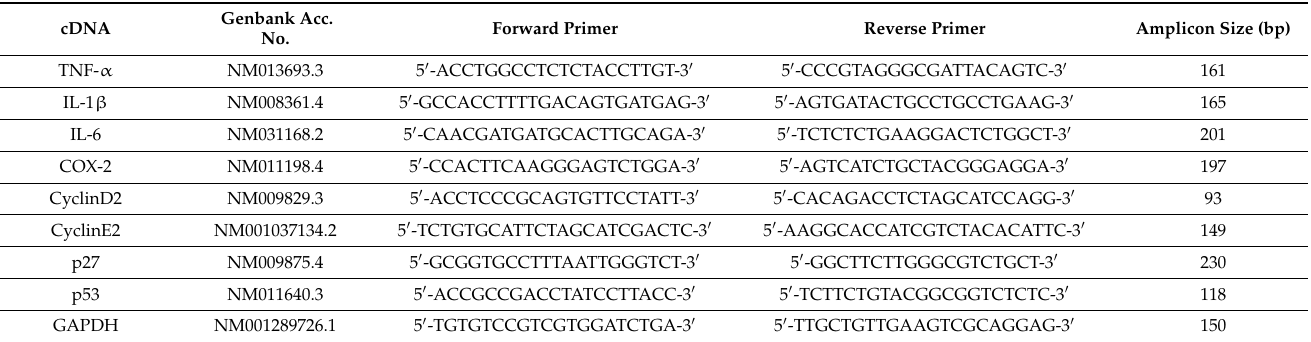
Table 1. Primer sequences and expected amplicon sizes for gene